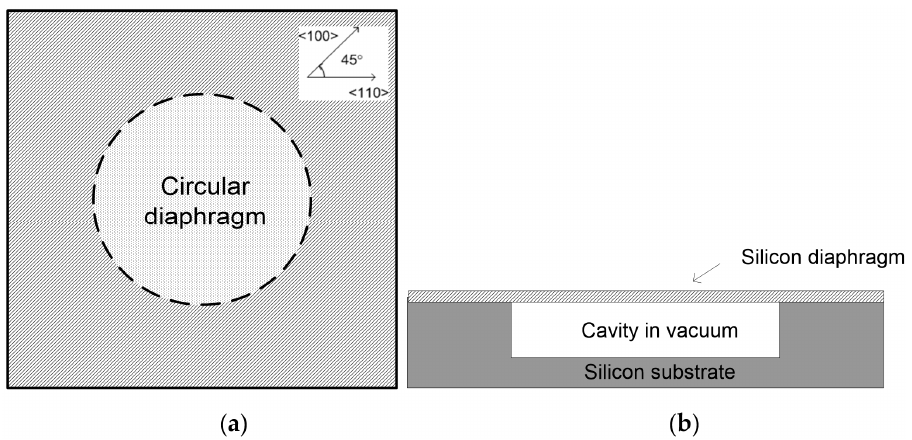
Figure 1. Schematic drawing of SCS diaphragm with sealed cavity ( a ) top view (inset is the crystal orientation of the device); ( b ) cross-section view.